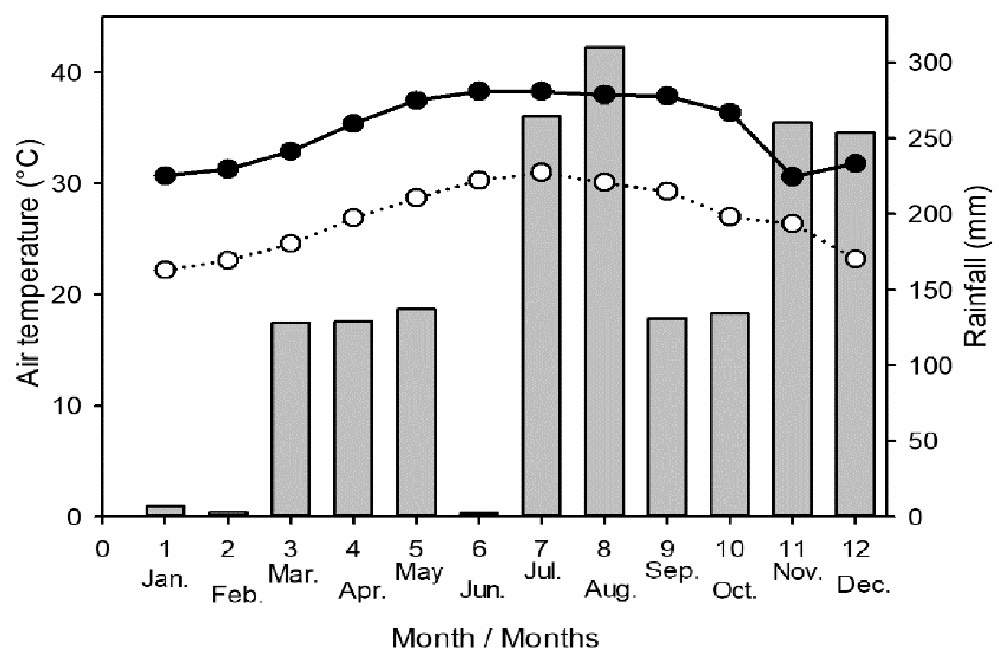
Figure 2. Gaussen diagram showing monthly rainfall (mm; bars) and maximum (black circles) and